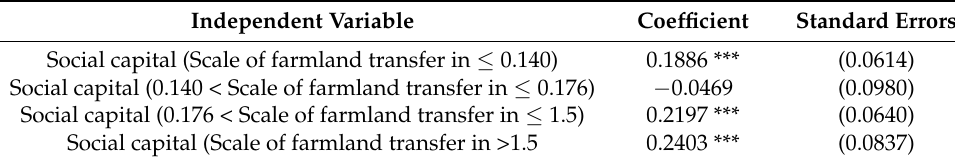
Table 7. Threshold regression